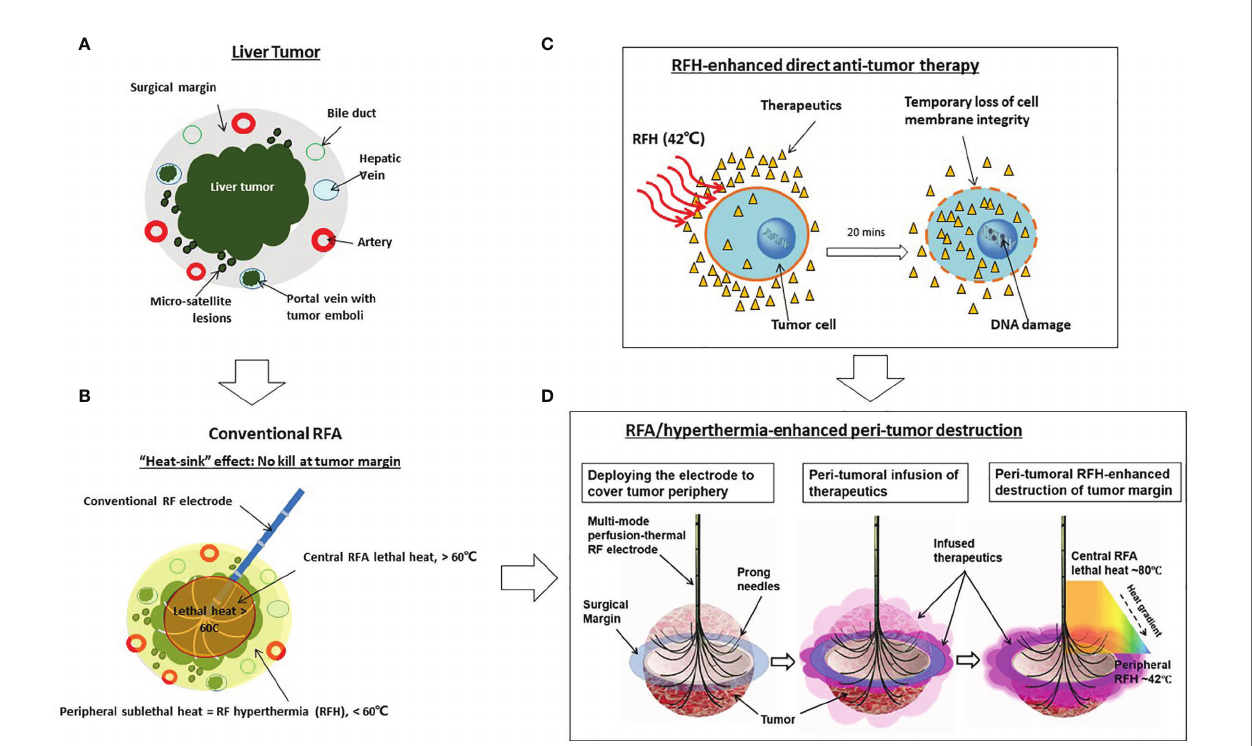
FIGURE 1 | Development of the “ one-stop-shop ” interventional technique for locoregional treatment of medium-to-large liver tumors. (A) A cross-sectional view of a liver tumor with in fi ltrating border, micro-satellite lesions, and venous tumor emboli contained within the 1-cm surgical margin. (B) Conventional thermal ablation of medium-to-large tumor suffers from incomplete ablation at the tumor periphery. This is largely due to the “ heat sink ” effect associated with RFA, which results in sublethal hyperthermia (< 60°C) at the periphery of tumors. (C) The mechanism of RFH-enhanced anti-tumor therapy. Therapeutic agents, introduced into the tumor via either percutaneous needle injection or intraarterial catheter infusion, dwell primarily in the extracellular space with very limited intracellular uptake. Applying 42°C- RFH for 20 mins facilitates a temporary loss of cell membrane integrity, allowing therapeutic agents to enter cells and exert cytotoxic effects more readily. (D) Our strategy of the “ one-stop-shop ” solution to overcoming incomplete ablation of medium-to-large liver tumors. The multimodal perfusion thermal electrode permits (i) creation of lethal RFA heat (60-100°C) for necrotic ablation at the tumor center; (ii) direct infusion of therapeutics into the tumor periphery (surgical margin), and (iii) maintenance of a stable sublethal peritumoral hyperthermia (~42°C), which enhances destruction of tumor margins by increasing the uptake and cytotoxicity of therapeutic